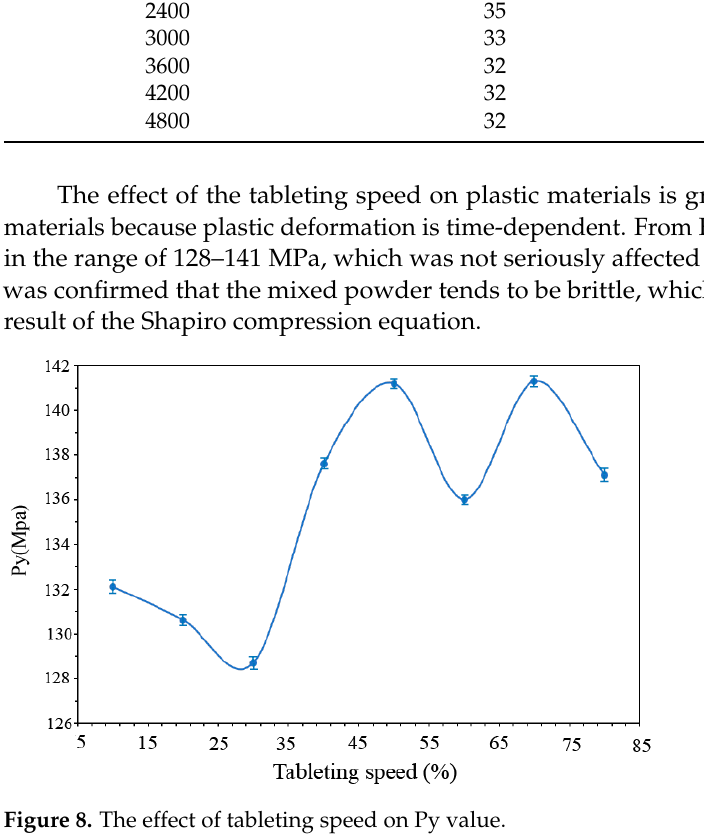
Figure 8. The effect of tableting speed on Py